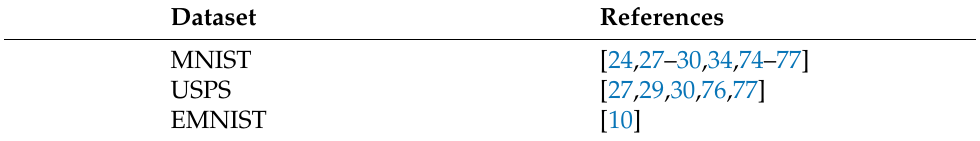
Table 5. The datasets for handwritten digit or character recognition reported in the primary studies.